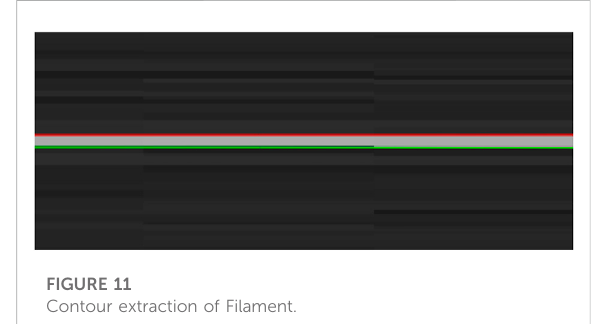
FIGURE 11 Contour extraction of